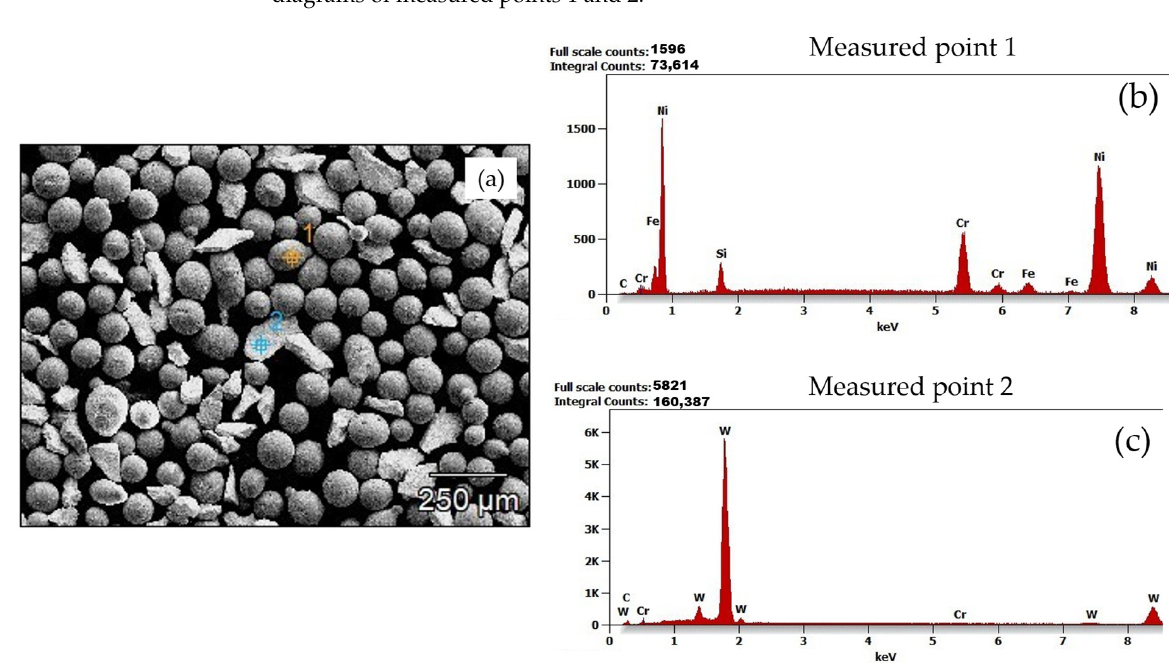
Figure 6. Microanalysis of powder particles ( a ) acquired SEM image of PE powder showing its morphology and measured points under analysis ( b , c ) Energy-dispersive X-ray spectrometry (EDS) diagrams of measured points 1 and